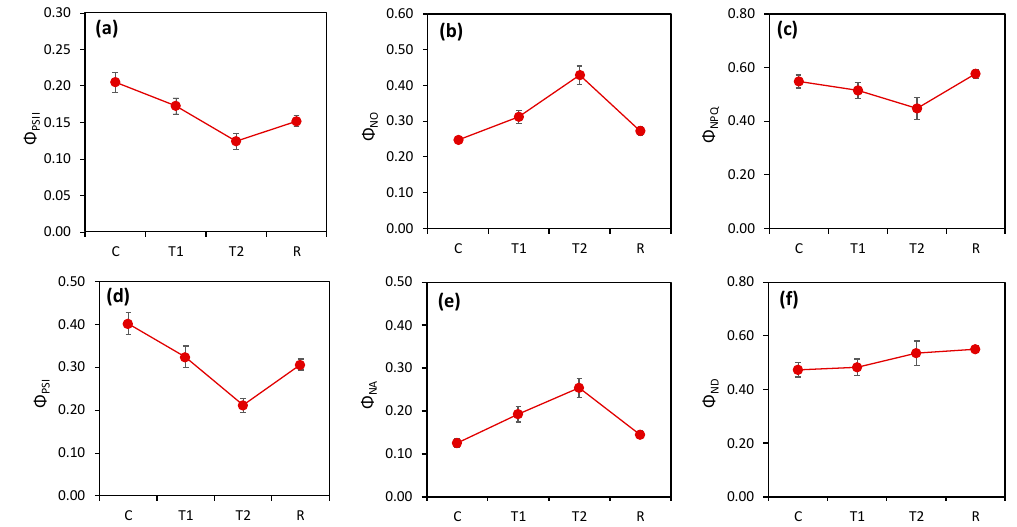
Figure 3. Heat e ff ect on parameters measured by Dual-PAM (the average from all varieties): C, control; T1, thermal e ff ect in the first phase; T2, thermal e ff ect in the second phase; R, recovery phase. ( a ) The e ff ective quantum yield of photosystem II (PSII) ( Φ PSII ); ( b ) the fraction of energy captured by PSII passively dissipated in the form of heat and fluorescence ( Φ NO ); ( c ) the quantum yield of regulated nonphotochemical quenching in PSII ( Φ NPQ ); ( d ) the e ff ective quantum yield of PSI ( Φ PSI ); ( e ) the quantum yield of PSI nonphotochemical quenching caused by the acceptor side limitation, i.e., the fraction of overall P700 that could not be oxidized in a given state ( Φ NA ); ( f ) the quantum yield of PSI nonphotochemical quenching caused by the donor side limitation, i.e., the fraction of overall P700 that was oxidized in a given state ( Φ ND ). The points represent the mean values for all measured wheat plants of all genotypes. The error bars represent the standard error of the means.